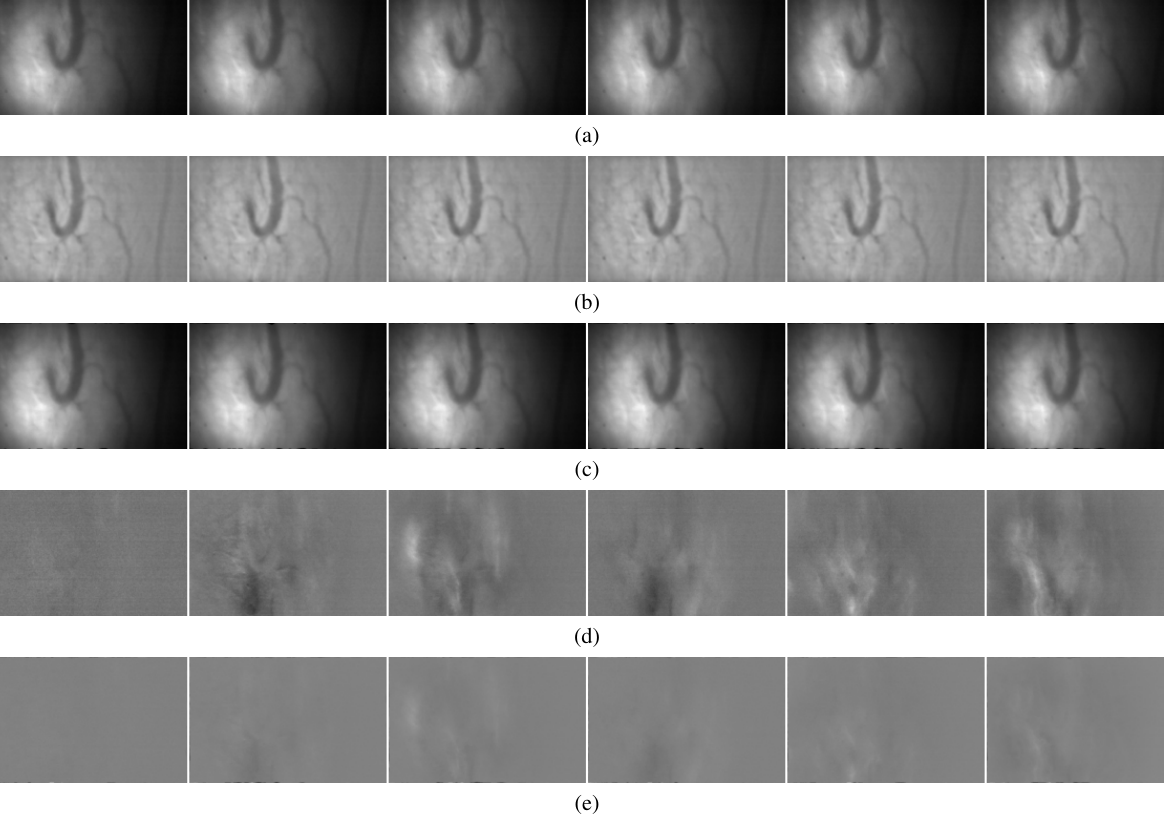
Figure 1. The every 165-th frame of the contrast-enhanced initial image sequence (a), the preprocessed image sequence (b), the registered image sequence (c), the difference between the first frame and n -th frame of the initial (d) and registered (e) sequences (contrast enhanced).